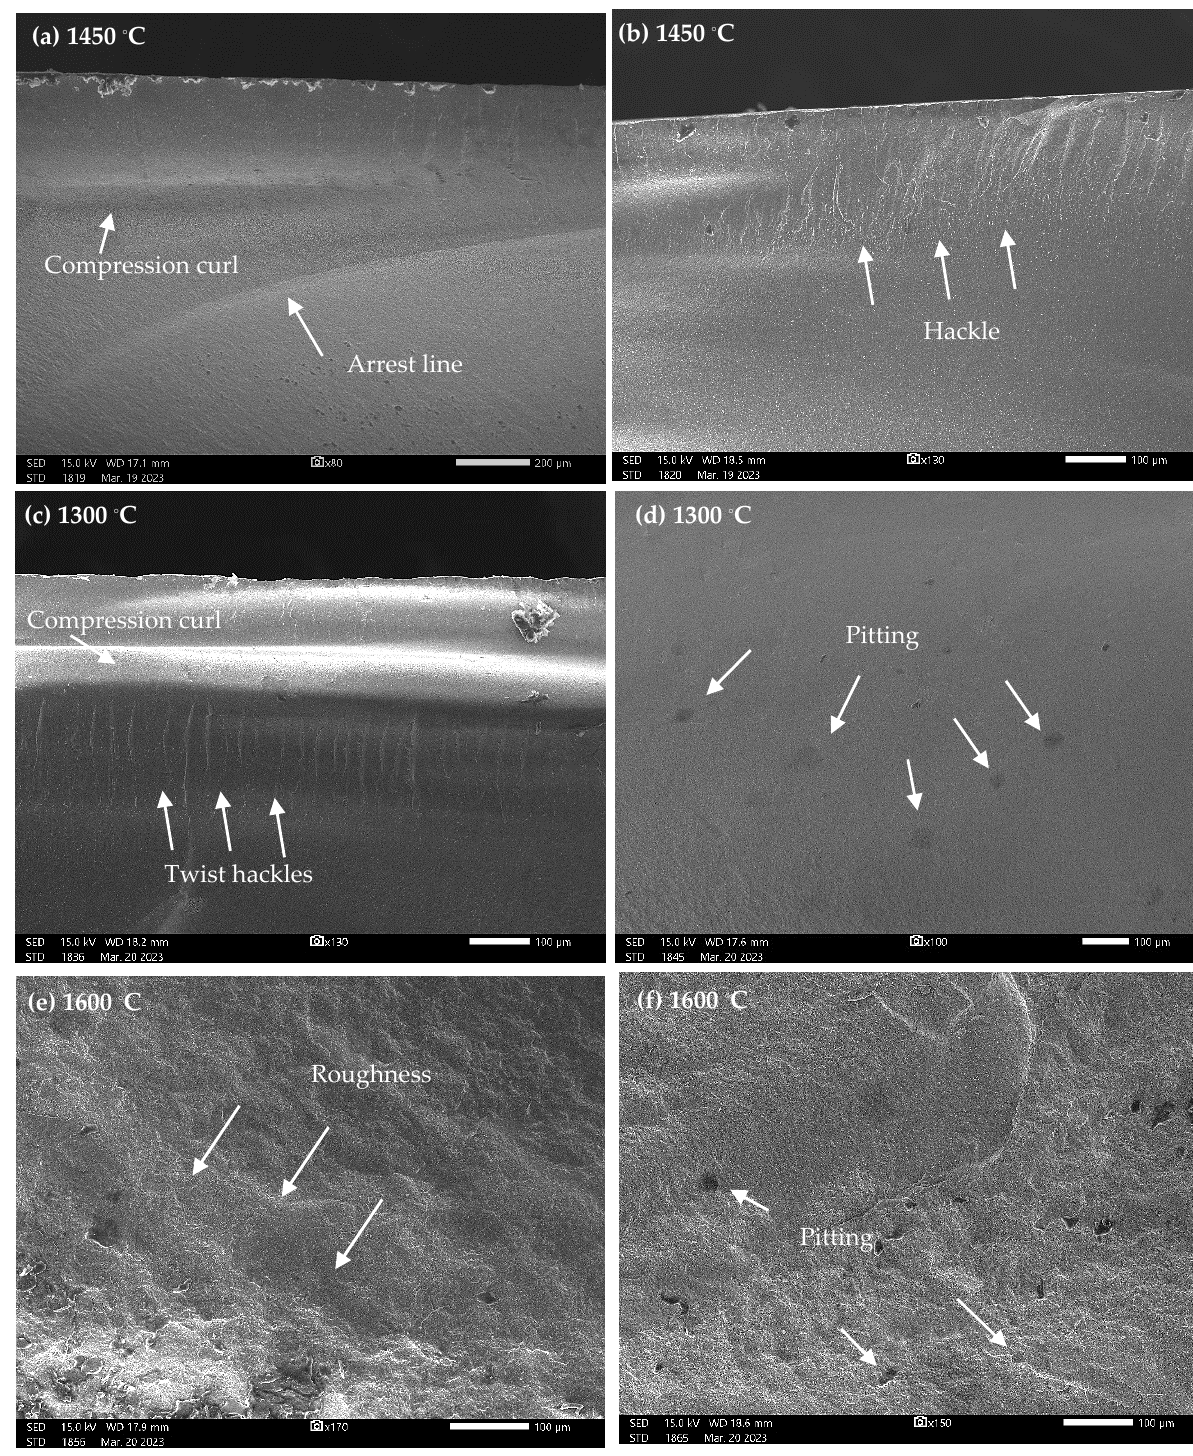
Figure 4. Representative SEM images of DD cube ONE ML (4Y-TZP) at different sintering temperatures. ( a ) A sample sintered at 1450 ◦ C showing a compression curl along with an arrest line. ( b ) Higher magnification shows the hackle lines. ( c ) A sample sintered at 1300 ◦ C showing a compression curl along with twist hackles. ( d ) Increased number of pitting is also seen in samples sintered at 1300 ◦ C. ( e ) A sample sintered at 1600 ◦ C showing increases in surface roughness. ( f ) Pitting can also be seen in samples sintered at 1600 ◦ C.